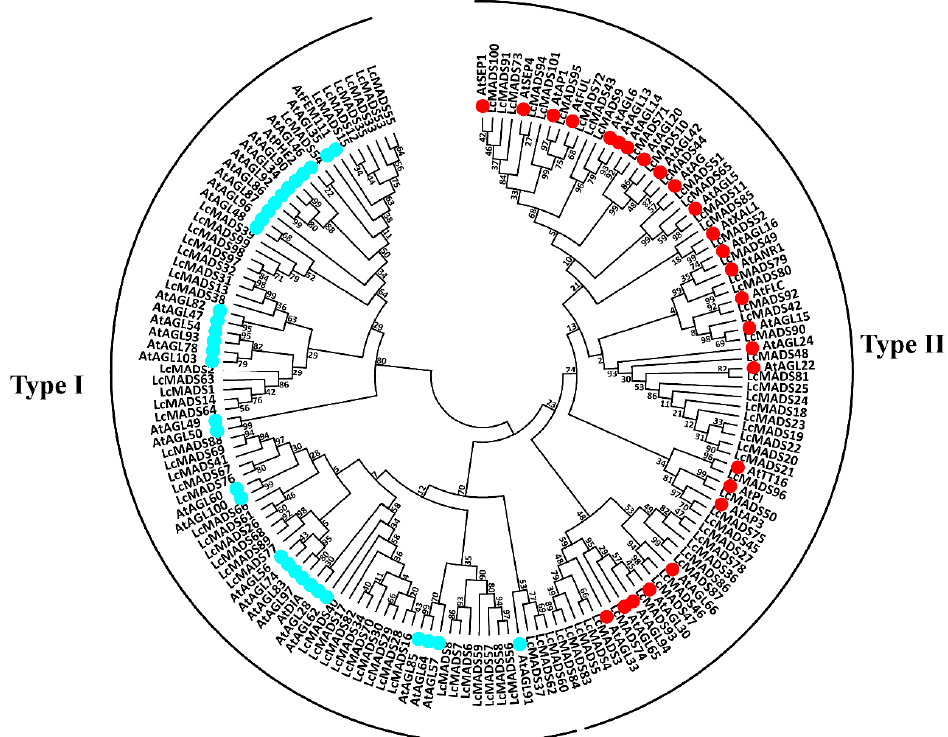
Figure 2. Phylogenetic analysis of litchi and Arabidopsis MADS-box proteins. A total of 58 representative MADS-box proteins from different subfamilies of Arabidopsis were used to construct the phylogenetic tree by the maximum likelihood method. These MADS-box factors are classified into two clades, designated as type I and type II.